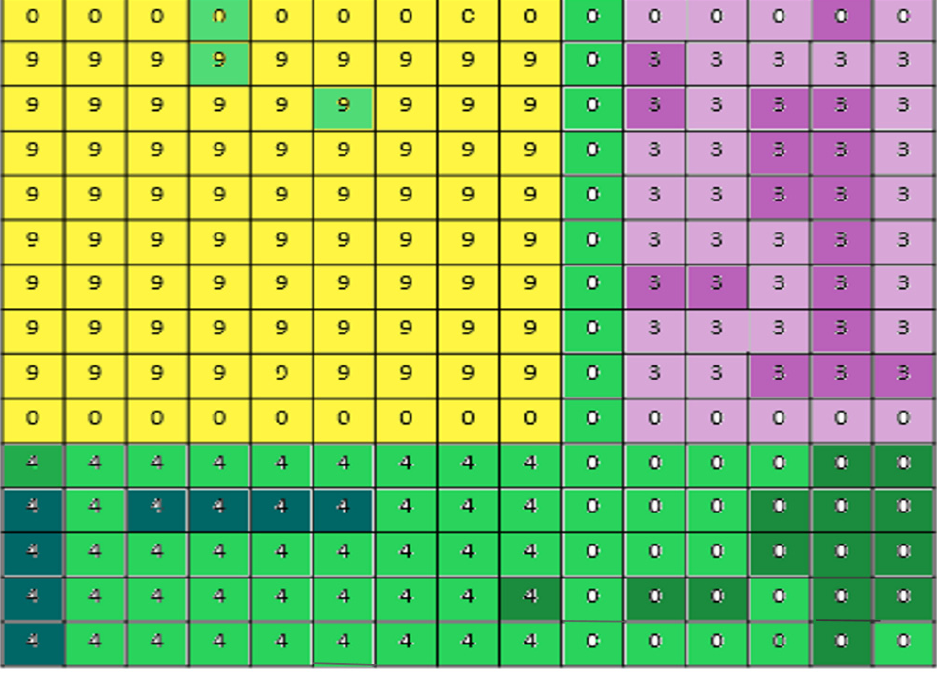
Figure 16. Spatial neighborhood representation of SE block after classification.